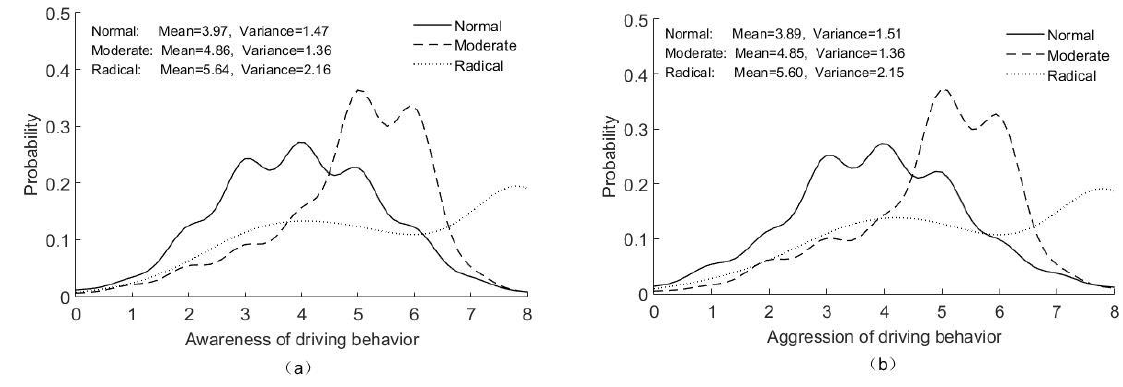
Figure 4. Different characteristics of driver behaviors: (a) Awareness distribution; (b) Aggression distribution